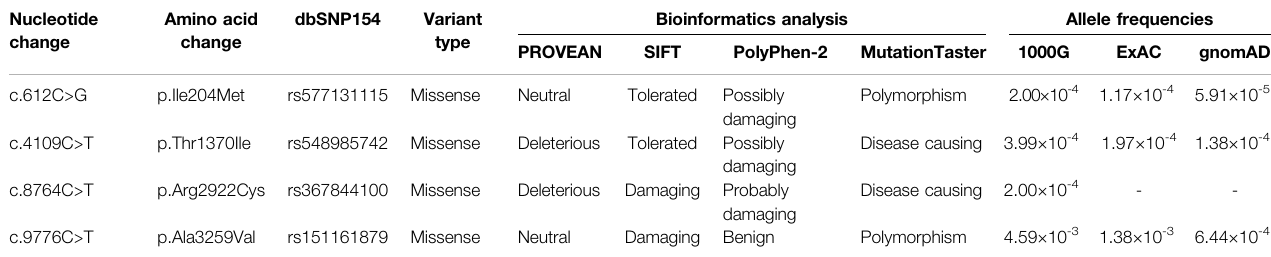
TABLE 2 | In silico analysis of the dynein axonemal heavy chain 17 gene variants. Nucleotide change